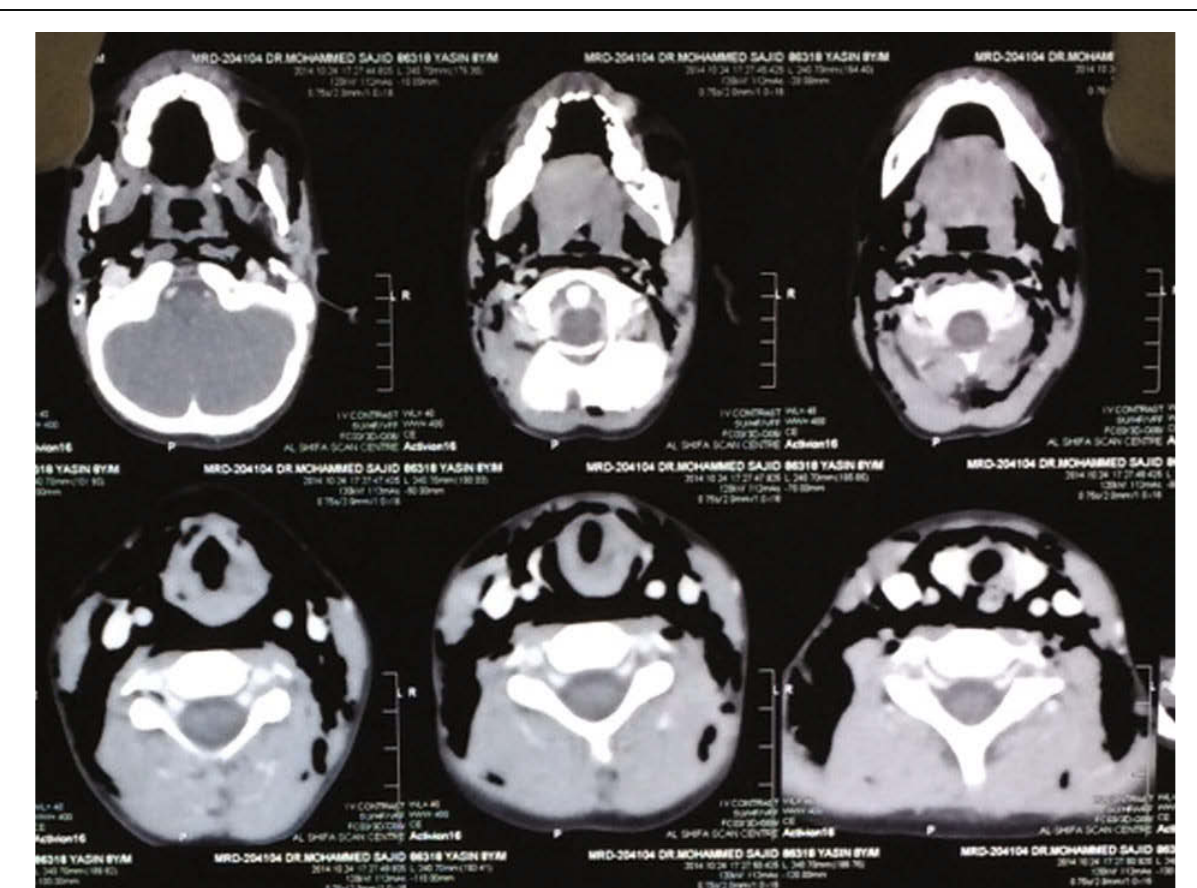
Computed tomography of the neck showing subcutaneous emphysema.